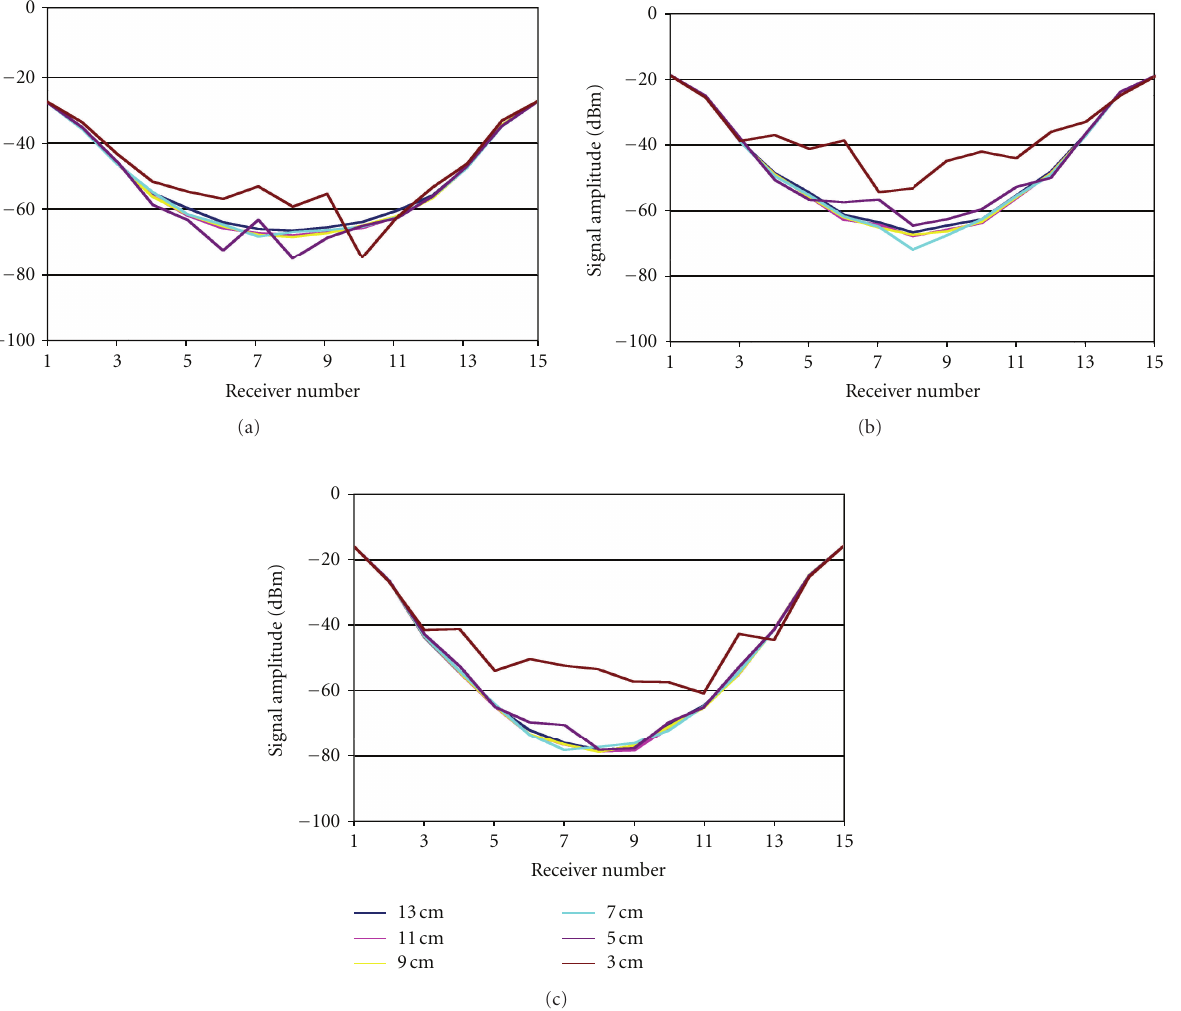
Figure 7: Signal amplitudes measured at the receivers with the clinical system in Figure 2 for a single transmitter over a range of antenna heights above the tank base (3, 5, 7, 9, 11, and 13cm) for (a) 900, (b) 1300, and (c) 1700 MHz,